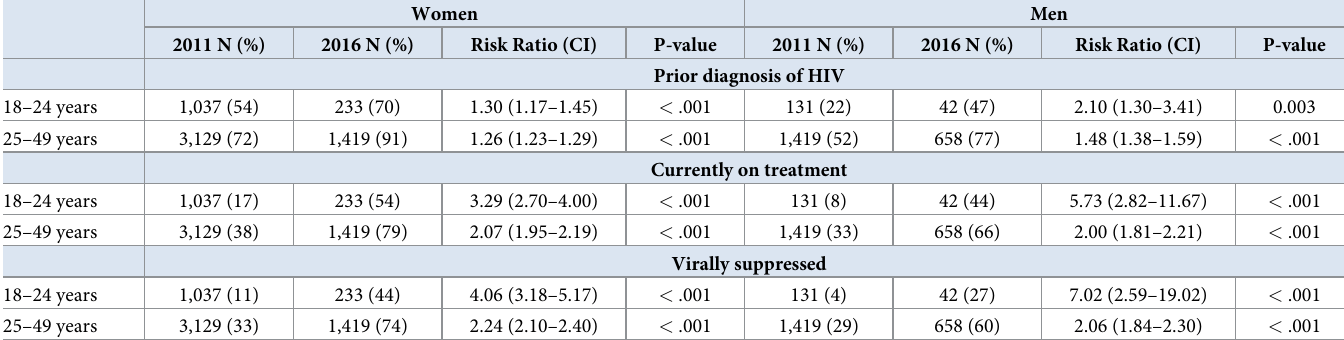
Table 3. Univariate prevalence ratios and 95% CIs for association between age group and HIV continuum of care measures among all persons testing HIV-positive by sex in 2011 and 2016.